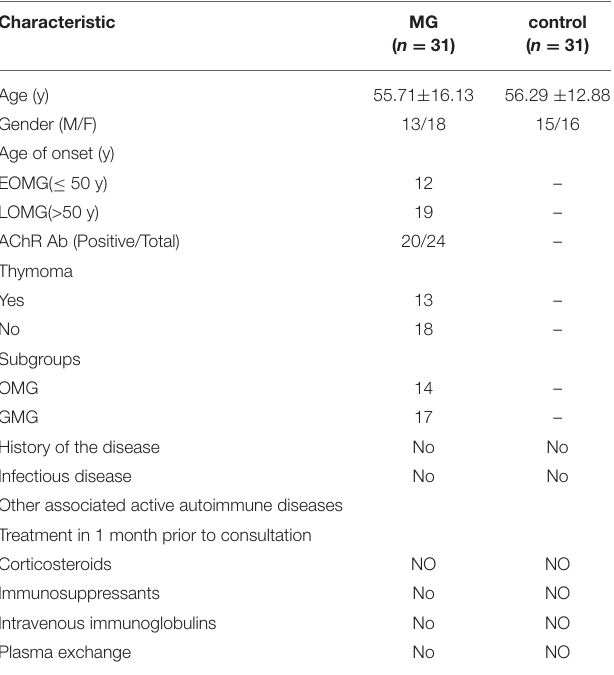
TABLE 2 | The primers used for real-time PCR. Name